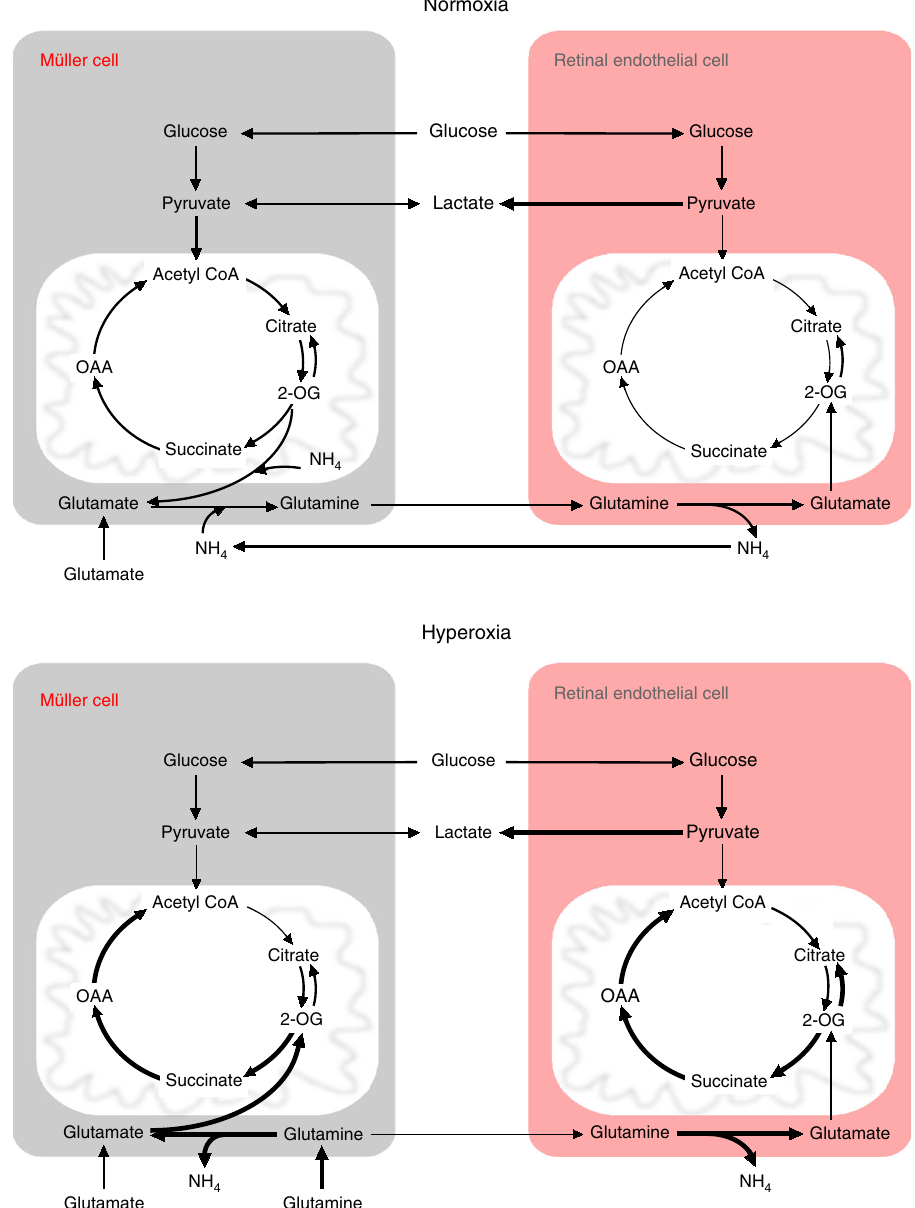
Fig. 4 Model depicting the re-programming of metabolism of Müller and retinal endothelial cells in response to hyperoxia. In normal conditions, Müller cells remove ammonium produced by other cell types in two steps by converting α -KG to glutamate and then glutamate to glutamine. Müller cells are the only cell type in retina known to ful fi ll all the glutamine requirements of the retina and are the only cells known to remove toxic ammonium formed by other cells in the retina. Retinal endothelial cells use aerobic glycolysis to produce energy and glutamine for growth. The lower panel shows the hyperoxic effect on metabolism of these cell types. In hyperoxia Müller cells stop producing glutamine and utilize it at increased rates for their energy needs by oxidative decarboxylation. Müller cells ful fi ll their energy needs by anaplerosis from glutamine when glycolytic fl ux entry to TCAC is blocked in hyperoxic conditions. This can lead to low glutamine levels in the retina for other cells types, including retinal endothelial cells. Glutaminolysis in retinal endothelial cells is also increased in response to hyperoxia, whereas, IDH back fl ux of citrate is decreased in response to hyperoxia. Overall hyperglutaminolysis in response to hyperoxia can lead to accumulation of toxic ammonium as well as a glutamine de fi cit. This would cause an overall metabolic imbalance leading to oxygen- induced growth one would hypothesize that the fl ux through PDH should increase. This is not the case as shown in a previous report in lung epithelium 29 . We measured the PDH and phospho-PDH levels in hyperoxia vs. normoxia cells, and found no difference. There are four paralogs of PDK in humans, PDK1, PDK 2, PDK 3 and PDK4 30 . Phosphorylation of PDK1 is under HIF regulation via 12 phosphorylation sites. Out of those, the most common one